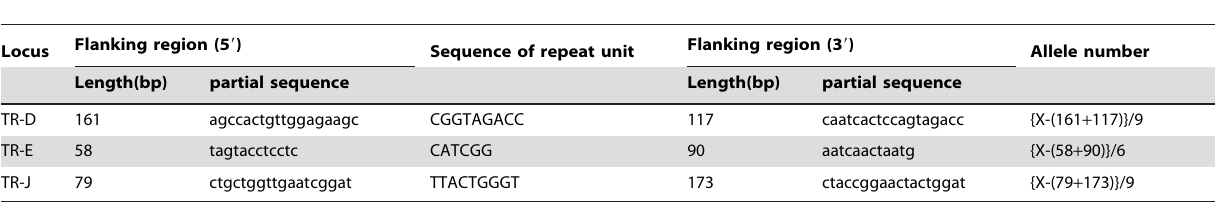
Formula for calculating the allele number on the basis of the fragment size.